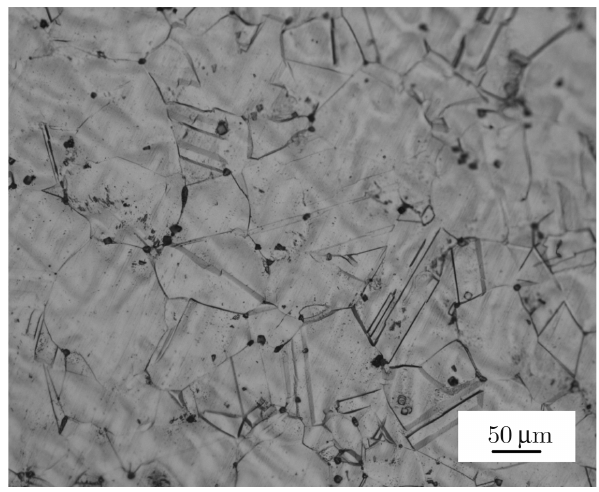
Figure 2: Microstructure of solution-treated alloy